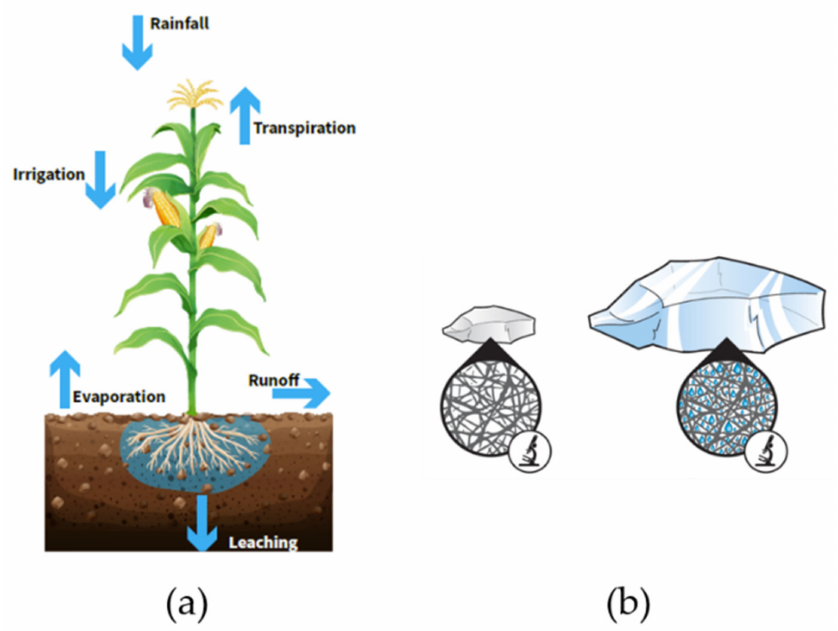
Figure 1. ( a ) Mechanisms of agricultural PAM uses and ( b ) SAP structure (left dried; right swelled). PAMs as soil conditioners are similar to a flocculant used in wastewater